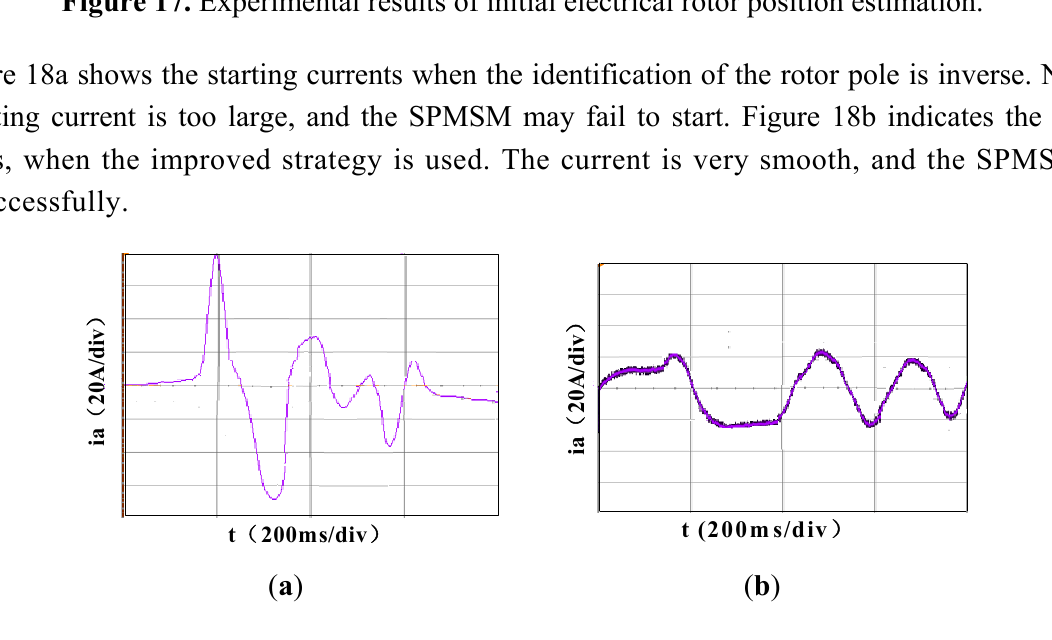
Figure 18. Comparison of starting current waveform. ( a ) Incorrect judgment of the pole; and ( b ) correct judgment of the